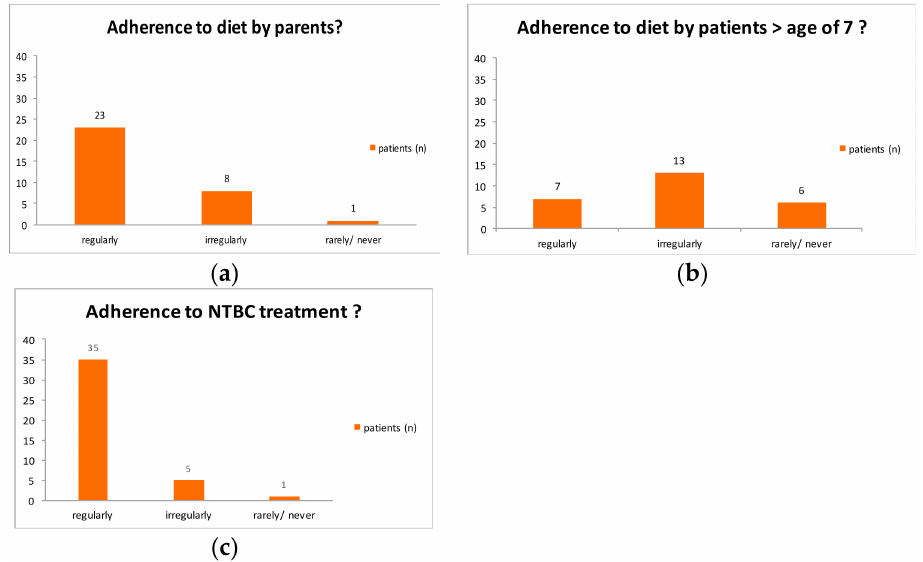
Figure A4. Adherence to diet and